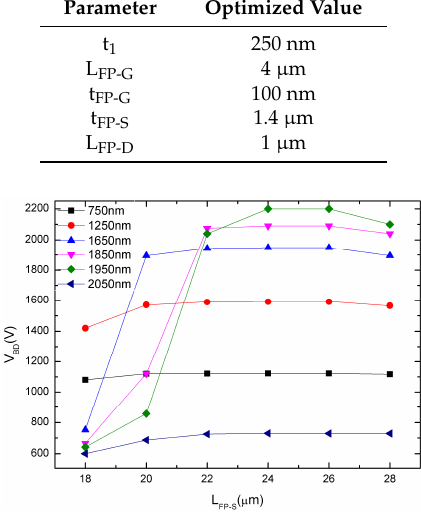
Table 1. Optimized parameter values.